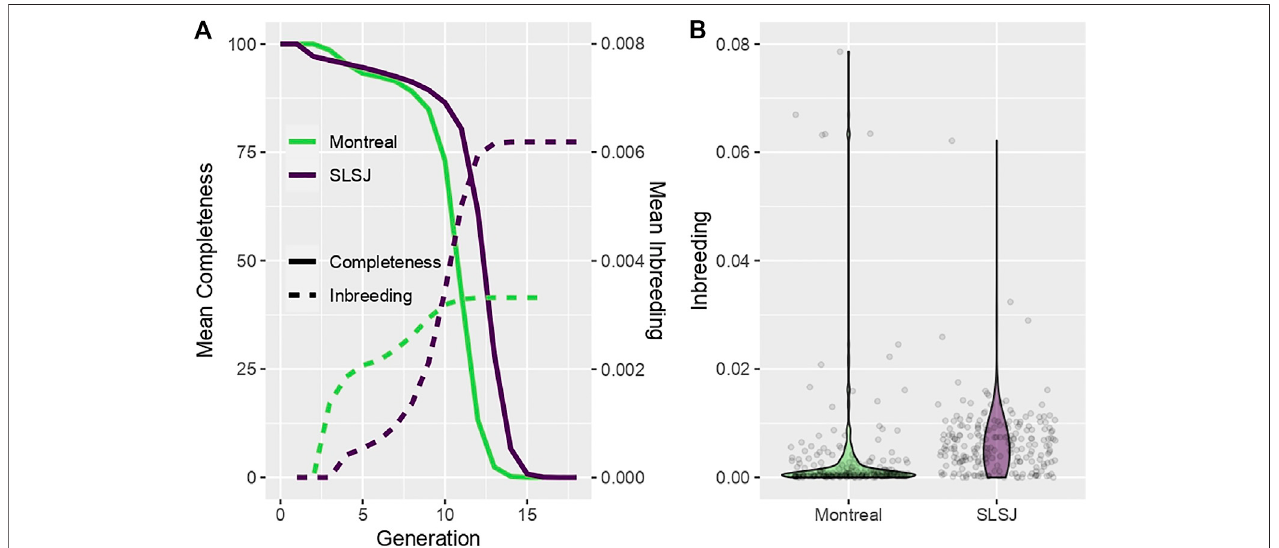
FIGURE 1 | Characteristics of the SLSJ and Montreal study genealogies. (A) Average across probands of the genealogical completeness and inbreeding coef fi cients calculated at each generation. (B) Violin plots of the distribution of inbreeding coef fi cients across probands (points are the inbreeding coef fi cients of the